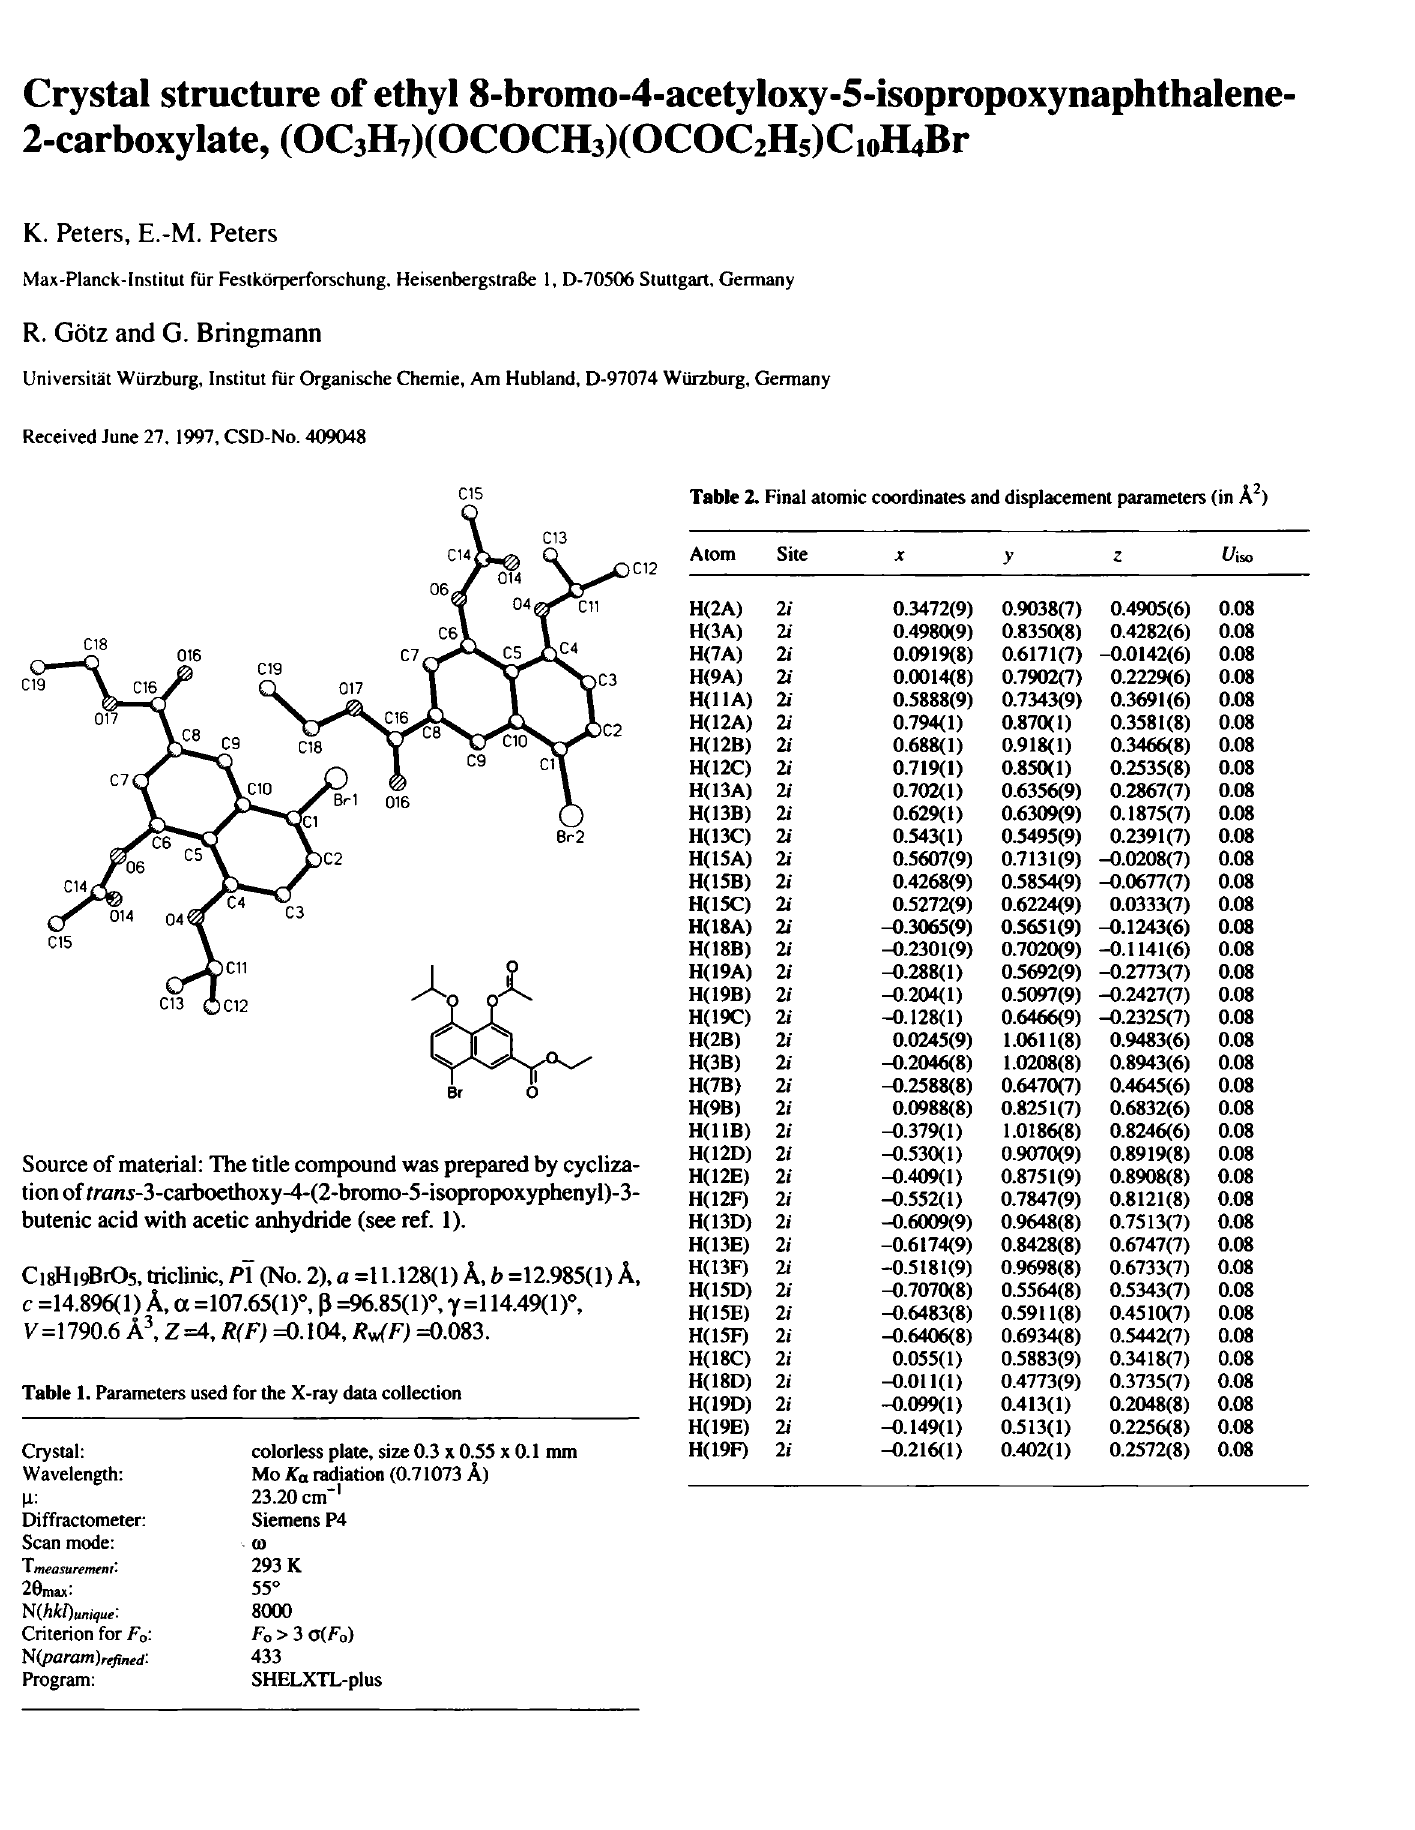
Table 1. Parameters used for the X-ray data collection Crystal: